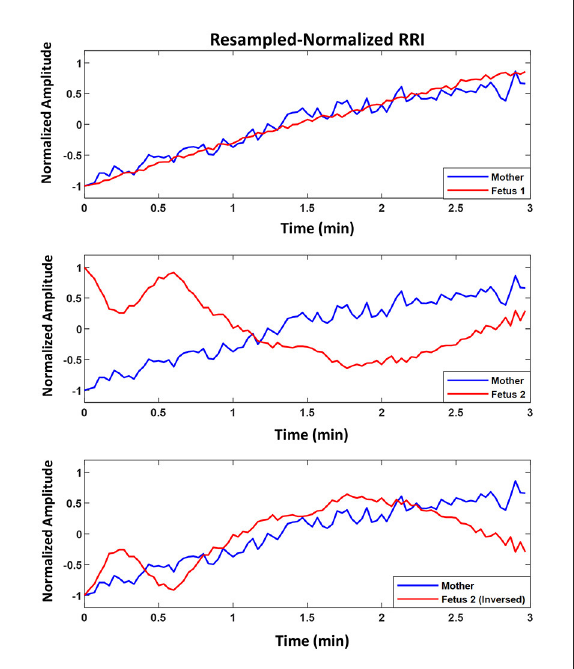
FIGURE3 Example of similarity trend of two fetuses from the same mother. The figure shows resampled normalized maternal (blue) and fetal (red) RR interval (RRI) from embryonic day 17.5 (ED17.5). The Top panel shows RRI for fetus 1 and the Middle and Bottom panels show the same for fetus 2. For fetus 1 (Top panel) , CC1, CC2, coherence low frequency (CLF) and coherence high frequency (CHF) values were as follows, 0.92, 0.92, 0.098, and 0.093, respectively. For fetus 2, the same